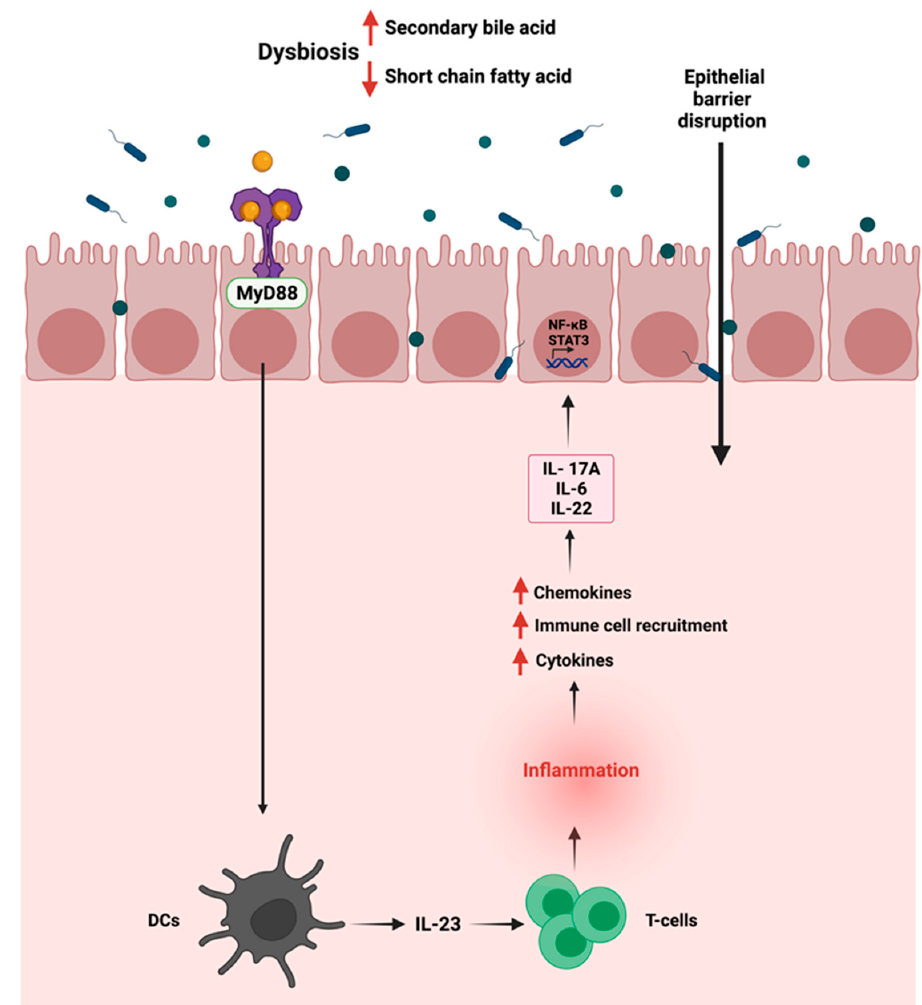
Figure 3. Schematic representation of the immune—gut interactions during GI cancer and how it influences the inflammatory responses. Due to gut dysbiosis, the low level of short chain fatty acids can lead to the activation of inflammatory pathway, the production of cytokines and chemokines and the activation of STAT3 and NF-kB signaling pathways. “Created with BioRender.com”.